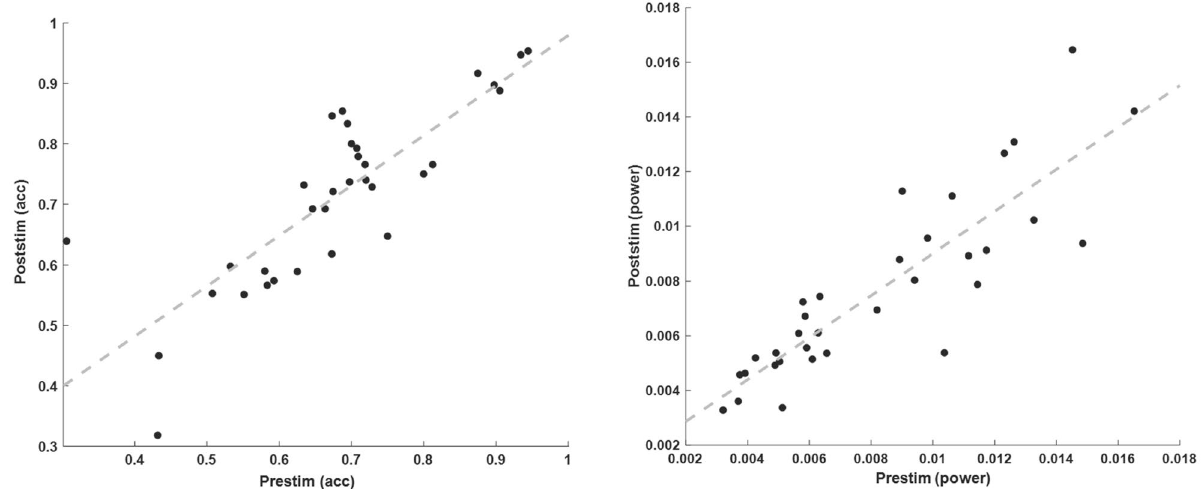
Figure 3. Relation between pre- and poststimulus time interval. Values for each of the 33 participants demonstrate a close correlation between both time periods (− 1.5:− 0.25 and 0:1 s) for the multivariate accuracies (left, r = 0.83) as well as for the high gamma band power extracted from the electrode FCz (right, r =